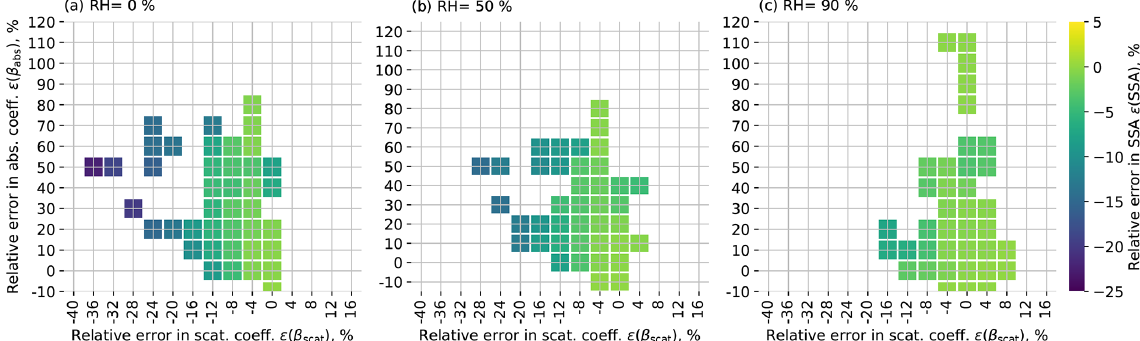
Figure 10. Relation between errors in SSA, scattering and absorption coefficients. Color represents the averaged (cid:15) (SSA) in the corresponding (cid:15) ( β scat ) and (cid:15) ( β abs )